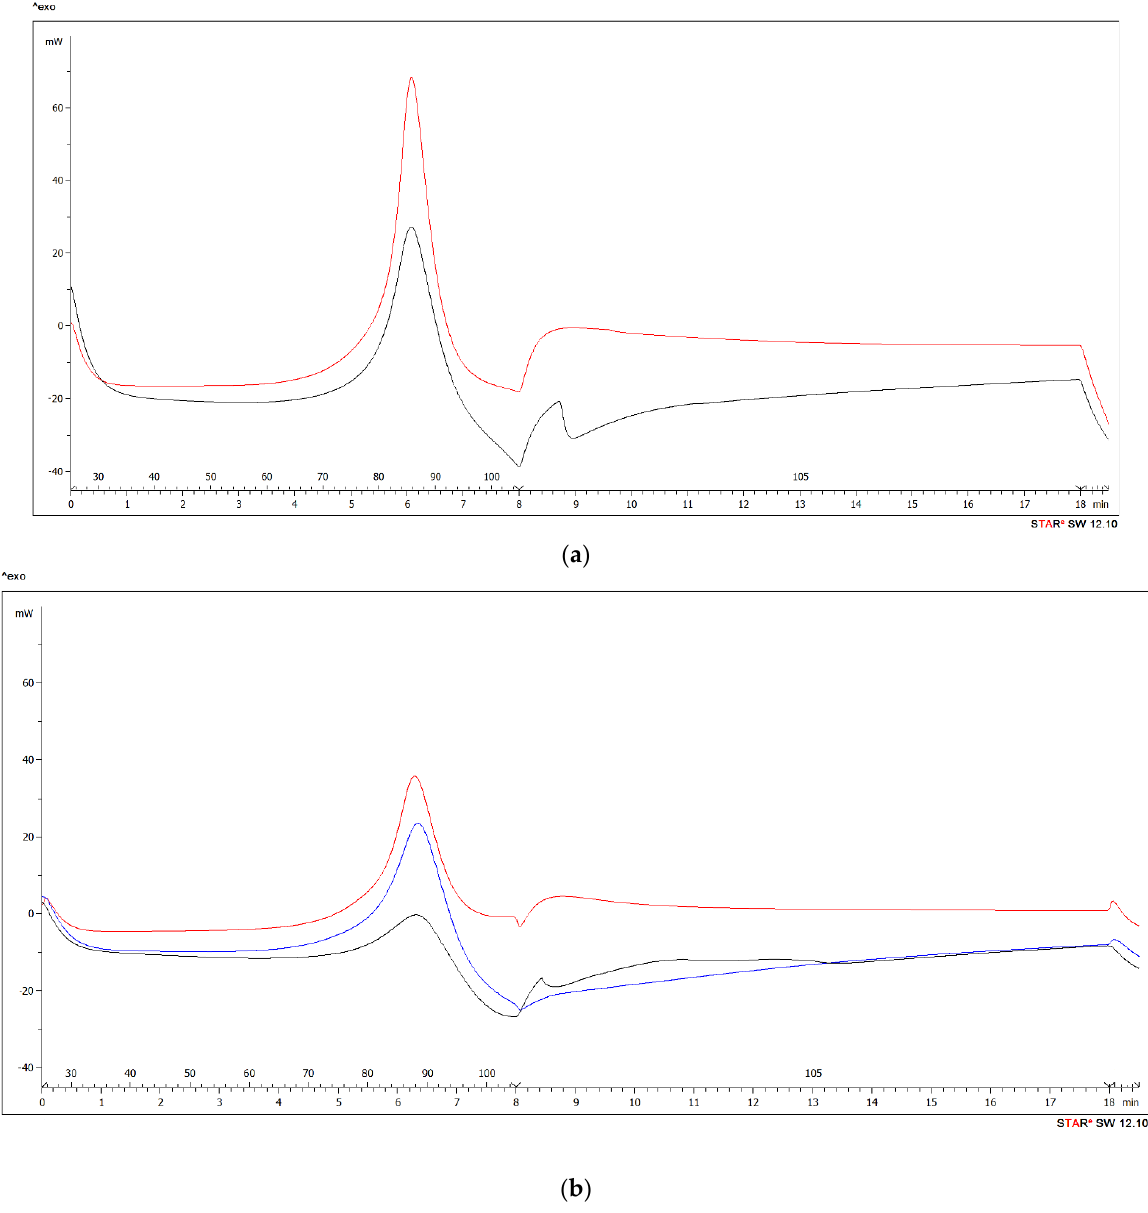
Figure 3. Differential scanning calorimetry (DSC) thermograph for ( a ) wheat flour (WF) at concentration 10% (red) and 20% (black) and ( b ) BB concentration 10% (red), 15% (blue) and 20% (black). Right half of the figure: the isothermal section at the temperature of 105 °C.